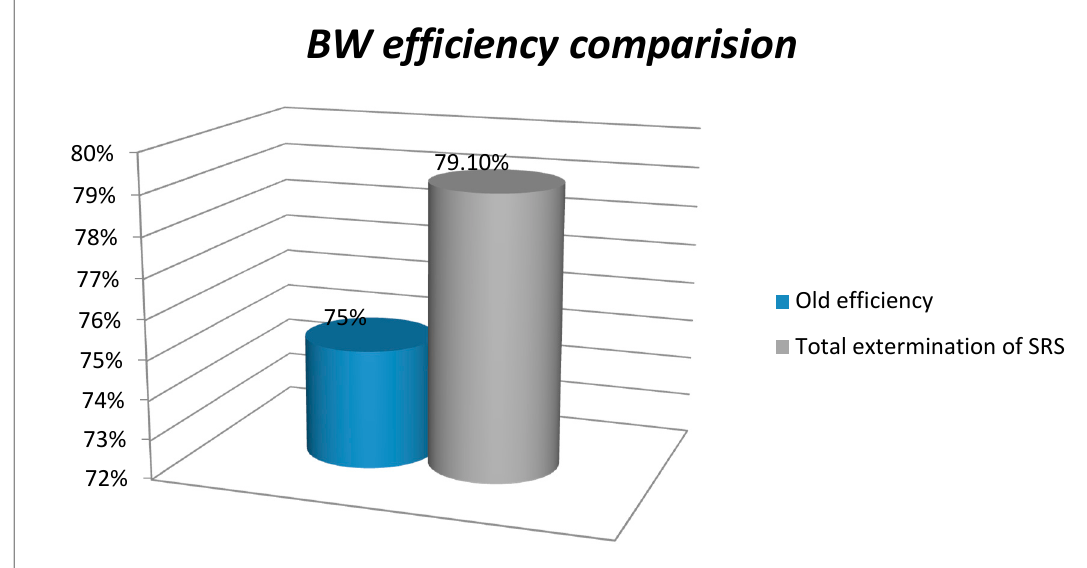
Figure 12. Bandwidth (BW) efficiency.